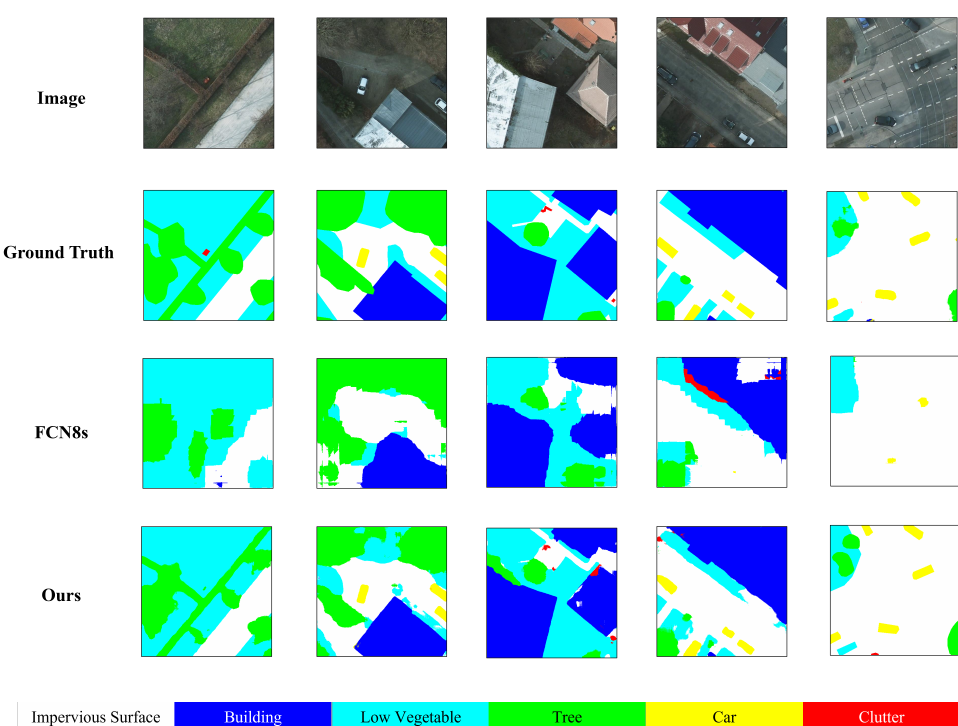
Figure 8. The 512 × 512 segmentation results on the Potsdam dataset. The FCN results are predicted by our implementation in the same hyperparameter settings, and the annotation colors are consistent with the ground truth.